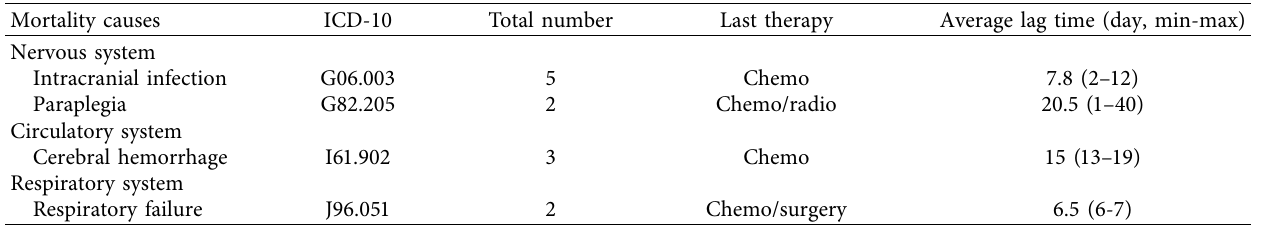
Table 3: Nontumor cause-specific mortality classification, last therapy, and lag time of 12 RB patients.